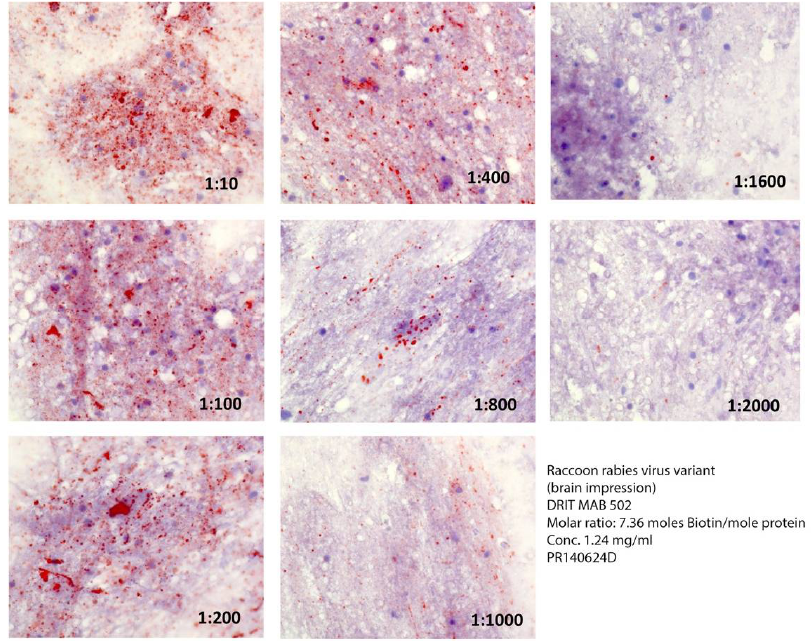
Figure 2. Comparative reactivity of serial dilutions of the DRIT MAB 502 at a ratio of 3.9 moles of Figure 1. Comparative reactivity of serial dilutions of the DRIT MAB 502 (in PBS) at a ratio of 7.4 moles biotin per mole of protein against a raccoon rabies virus variant. of biotin per mole of protein against a raccoon rabies virus variant. Rabies virus antigens appear as magenta inclusions against the bluish-purple background of uninfected CNS tissue in Figures